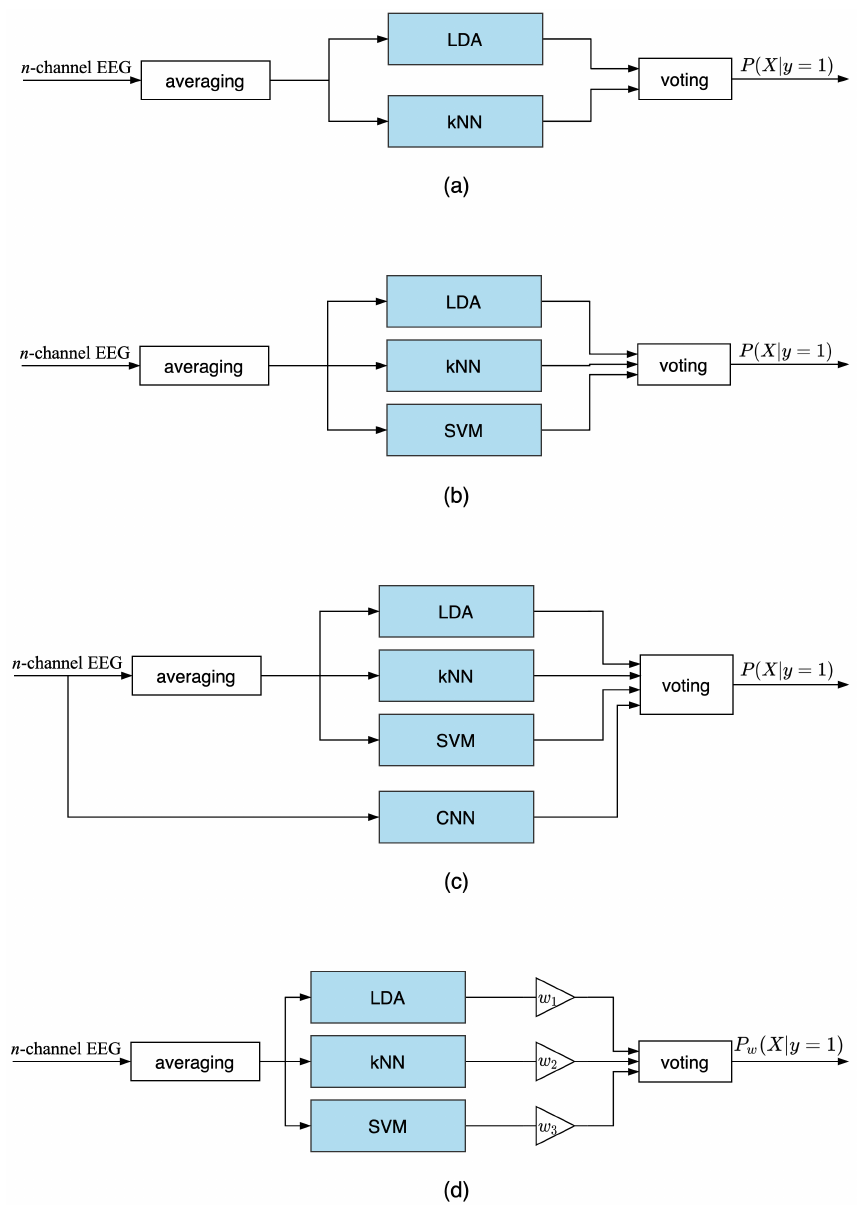
Figure 3. Ensemble averaging models: ( a ) LDA- k NN model; ( b ) LDA-SVM- k NN model; ( c ) LDA- SVM- k NN-CNN model; ( d ) W-LDA-SVM- k NN